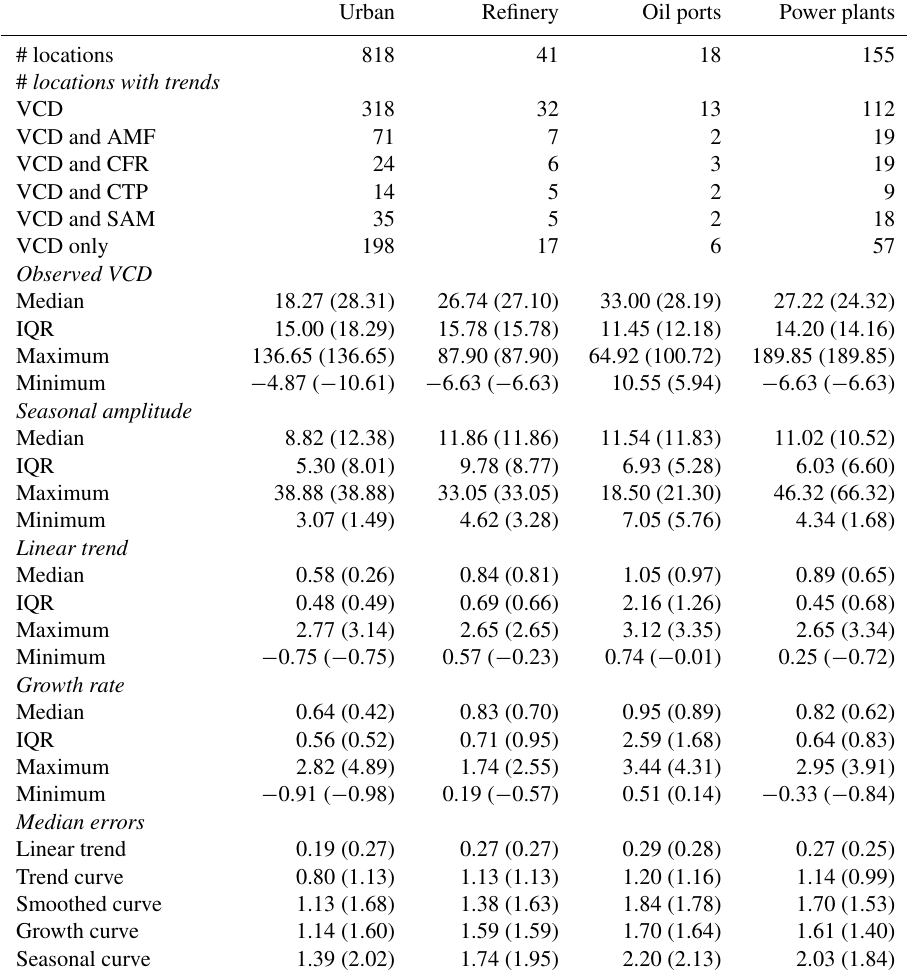
Table 1. Statistical summary of the DOMINO NO 2 vertical column density (VCD) analysis conducted at an approximate 10km radius over the target locations. Statistical values are shown for those locations which have a real VCD trend, i.e. those locations without a corresponding trend in either the air mass factor (AMF), cloud fraction (CFR), cloud-top pressure (CTP), or number of samples (SAM). Values in parenthe- ses correspond to statistics for all locations of a given category. VCD values are given in 10 14 moleculescm − 2 , and IQR is the interquartile